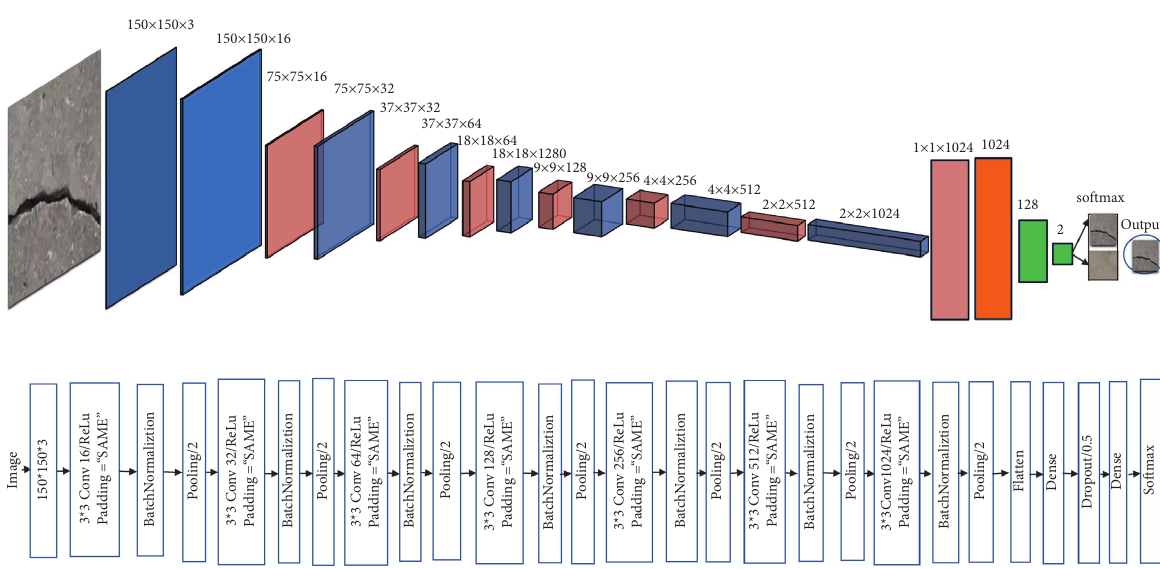
Figure 2: The architecture of